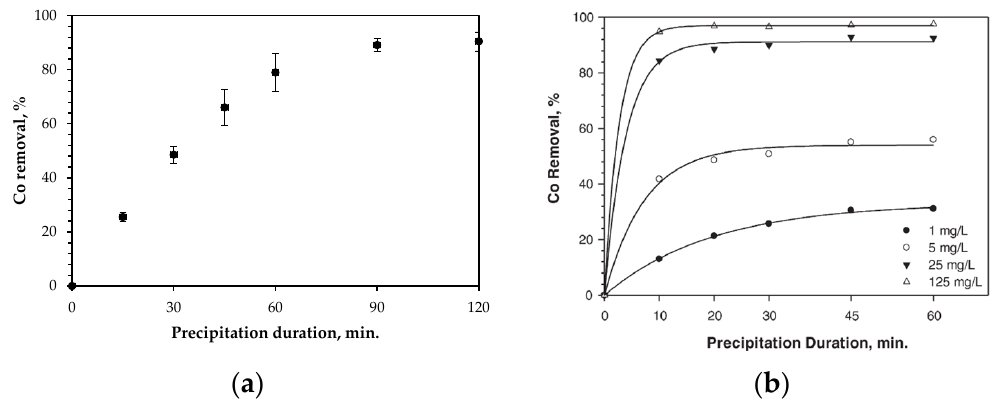
Figure 8. Cobalt precipitation rates. ( a ) Observed rate of Co precipitation (pH = 3.0, Eh = 1000 mV, 80 °C, 1 g/L Co). ( b ) Rates of Co precipitation reported in [1] . Table 7. Composition of the solutions from the ZPR leach, Fe-Mn and Co precipitation steps. All Concentrations in mg / L